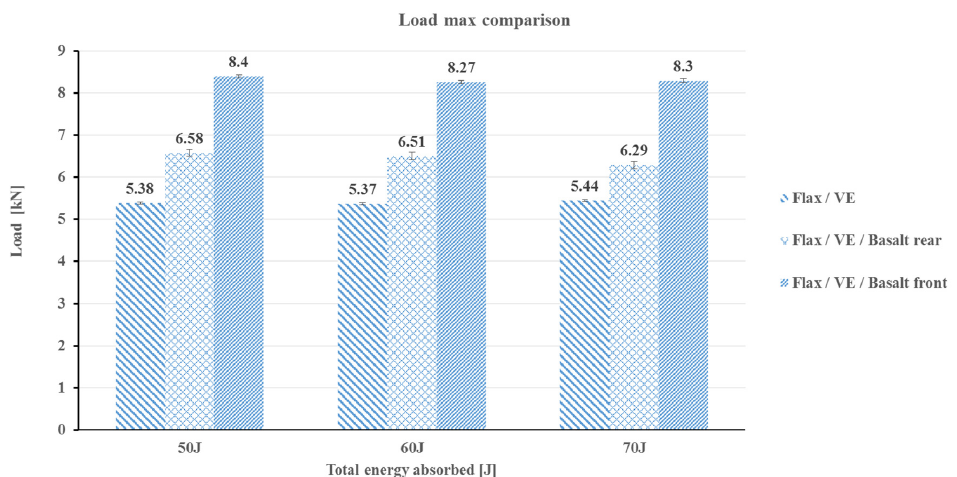
Figure 4. Maximum load comparison of different impact configurations of flax/VE, flax/VE/basalt rear, and flax/VE/basalt front for each incident energy employed.